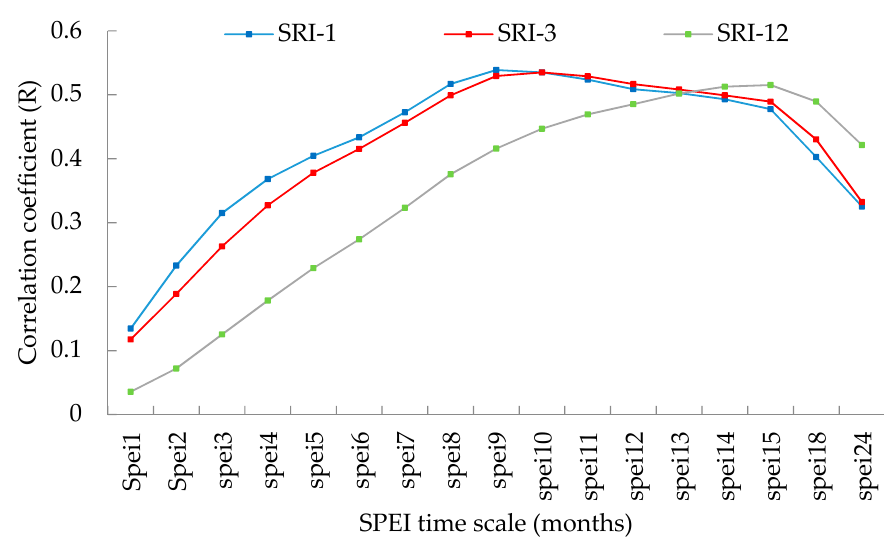
Figure 6. Correlation of SRI and SPEI at different timescales.